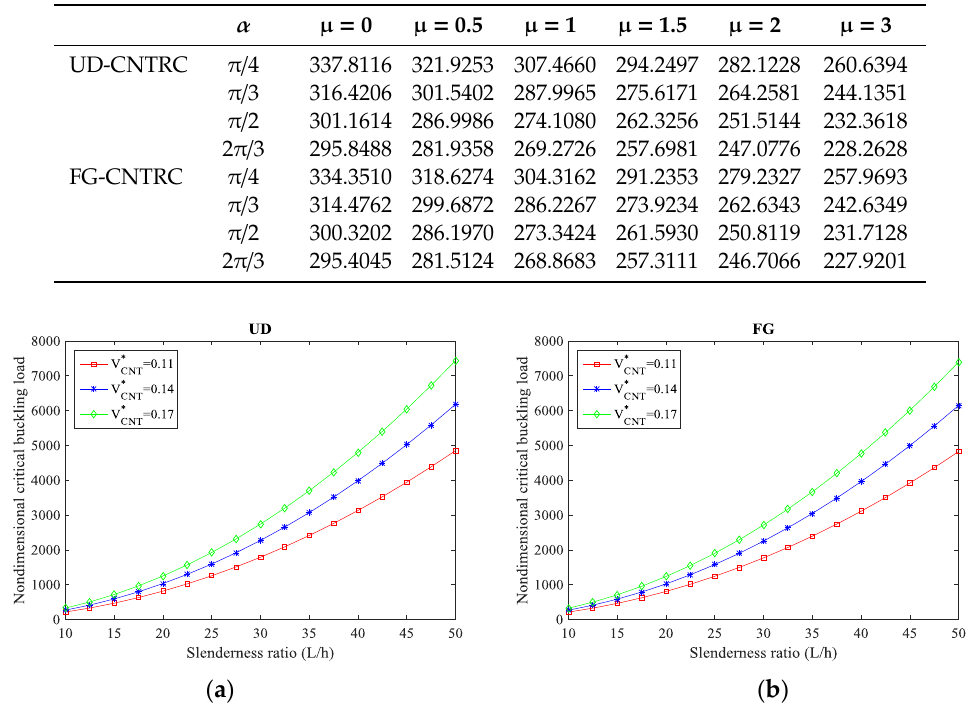
Table 11. E ff ect of the opening angle α on the nondimensional critical buckling load for C-C CNTRC = 0.14. curved beams with L / h = 10, V ∗ CNT